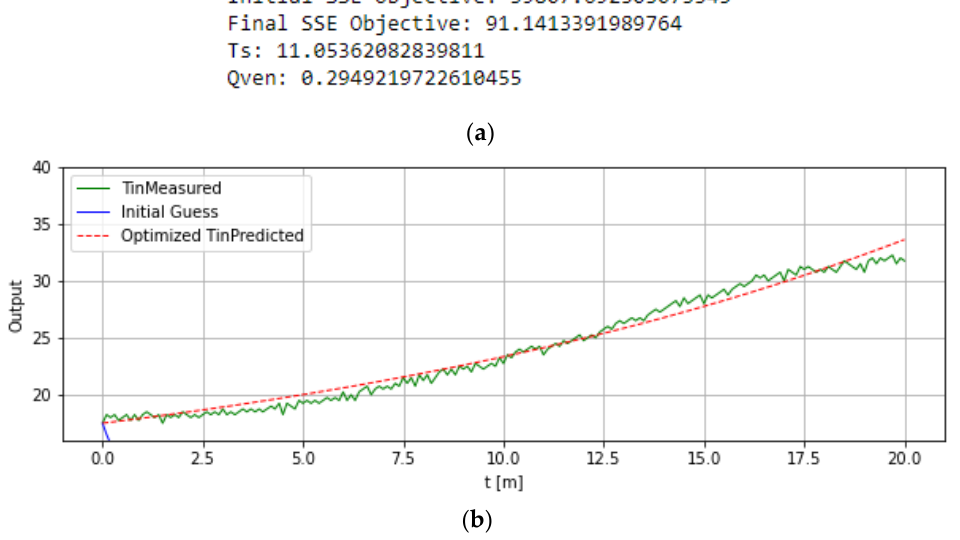
Figure 6. ( a ) Optimisation result; ( b ) measured versus simulated temperature [°C] .